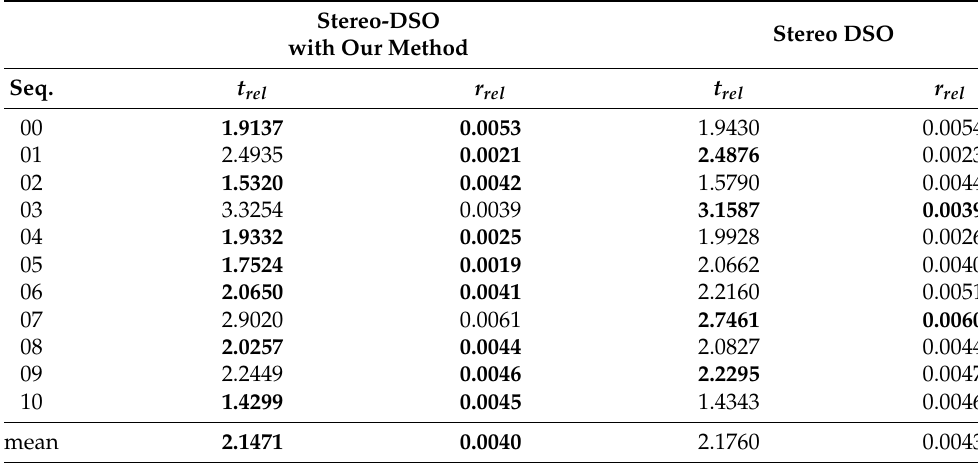
Table 2. Results of SO-DSO with and without the proposed method on the KITTI dataset. t